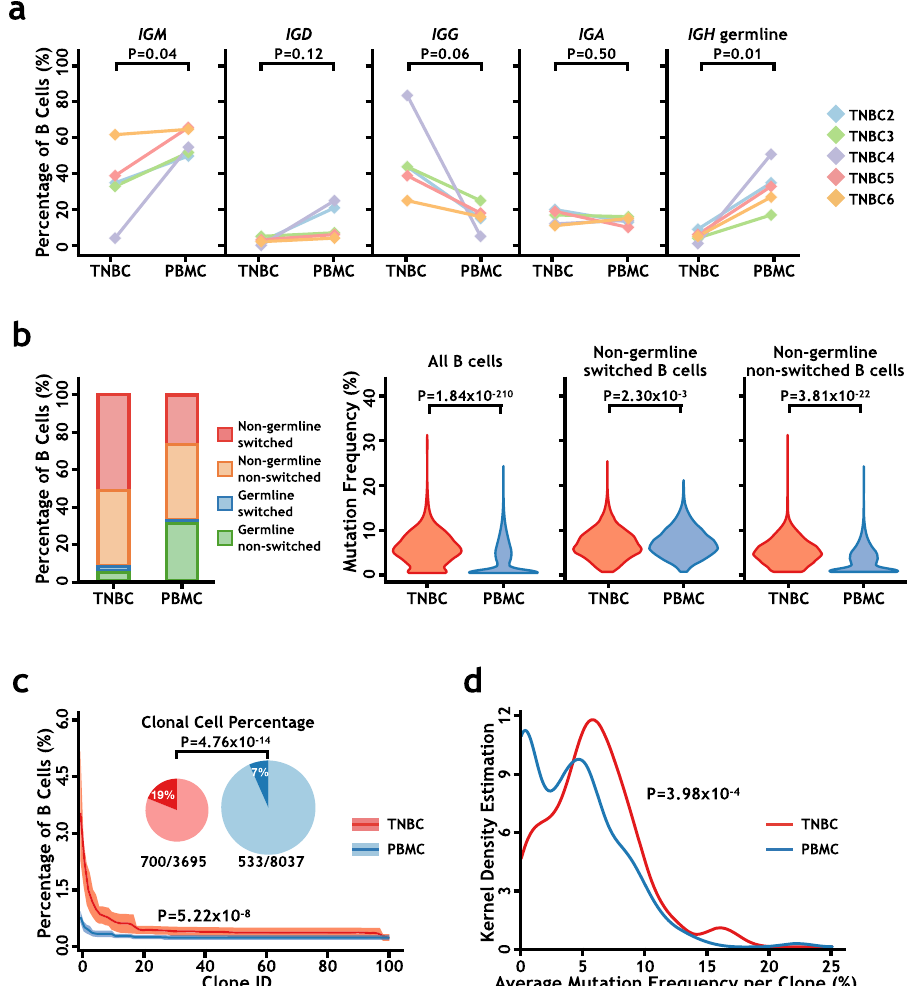
Fig. 2 Single-cell IGH analysis of B cells in tumor and peripheral blood samples from TNBC patients. a Distributions of IGH isotypes and germline IGH in B cells from triple-negative breast cancer (TNBC) and peripheral blood mononuclear cell (PBMC) samples. The p values were calculated by two-tailed paired Student ’ s t test. b Comparisons of IGH class switching recombination (CSR) and somatic hypermutation (SHM) between B cells from TNBC and PBMC samples. The left bar plot presents the percentages of cells that have germline or non-germline and class-switched or non-switched IGH alleles. The violin plots from left to right show the comparisons of SHM rates for all B cells, for non-germline and class-switched B cells, and for non-germline and non- switched B cells. The p values were calculated by two-tailed Student ’ s t test. c TNBC tumors contained signi fi cantly more and larger B cell clones. The percentages of clonal B cells in all B cells are presented by the upper pie charts, and the p value was calculated by two-sided Fisher ’ s exact test using SPSS software. The size distribution of B cell clones shows that TNBC samples have larger B cell clones than PBMC samples. The p value was calculated by two- tailed Student ’ s t test. d TNBC clones have higher IGH mutation frequencies than PBMC clones. The average IGH mutation frequencies of each clone are plotted versus the percent of clones with that mutation frequency. The p value was calculated by the two-sided Kolmogorov – Smirnov test. Source data are provided as a source data fi